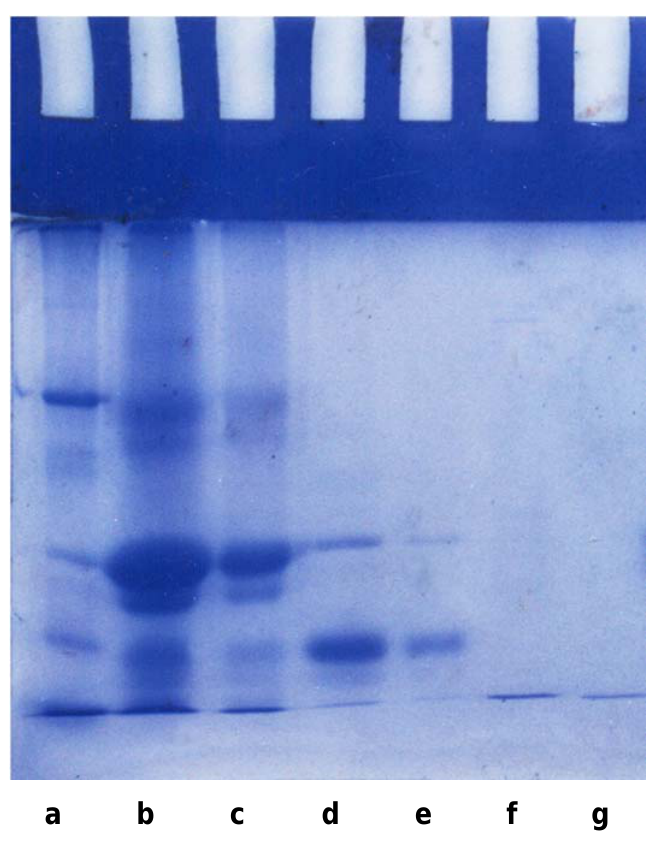
Figure 1: SDS-PAGE of purified Bungarus caeruleus toxin. Electrophoresis was carried out in 12% gel of 1mm thickness. Lanes: a = standard molecular weight markers; b and c = crude B ungarus caeruleus venom; d and e = gel filtration; f and g = purified